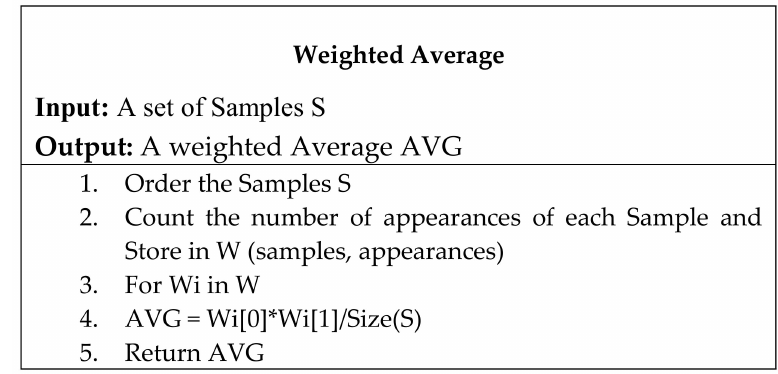
Figure 3. Average